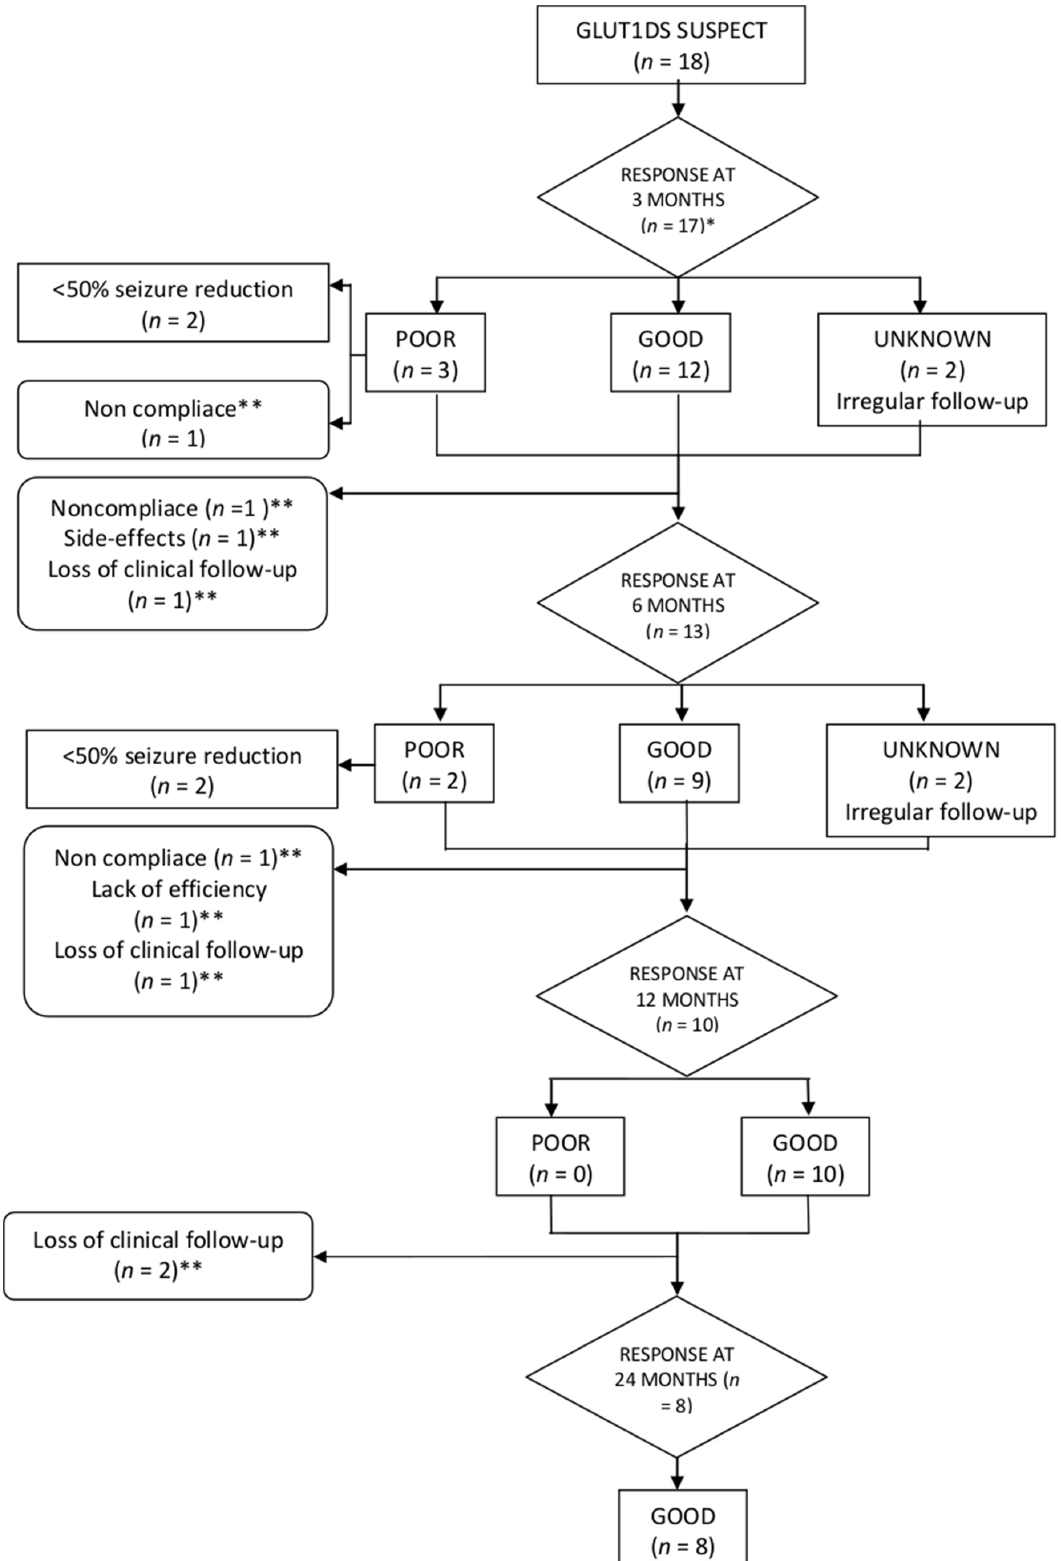
Figure 2. Evolution of the patients of the study. * One patient had not completed 3 months at the moment of the analysis. ** KDT withdrawn.